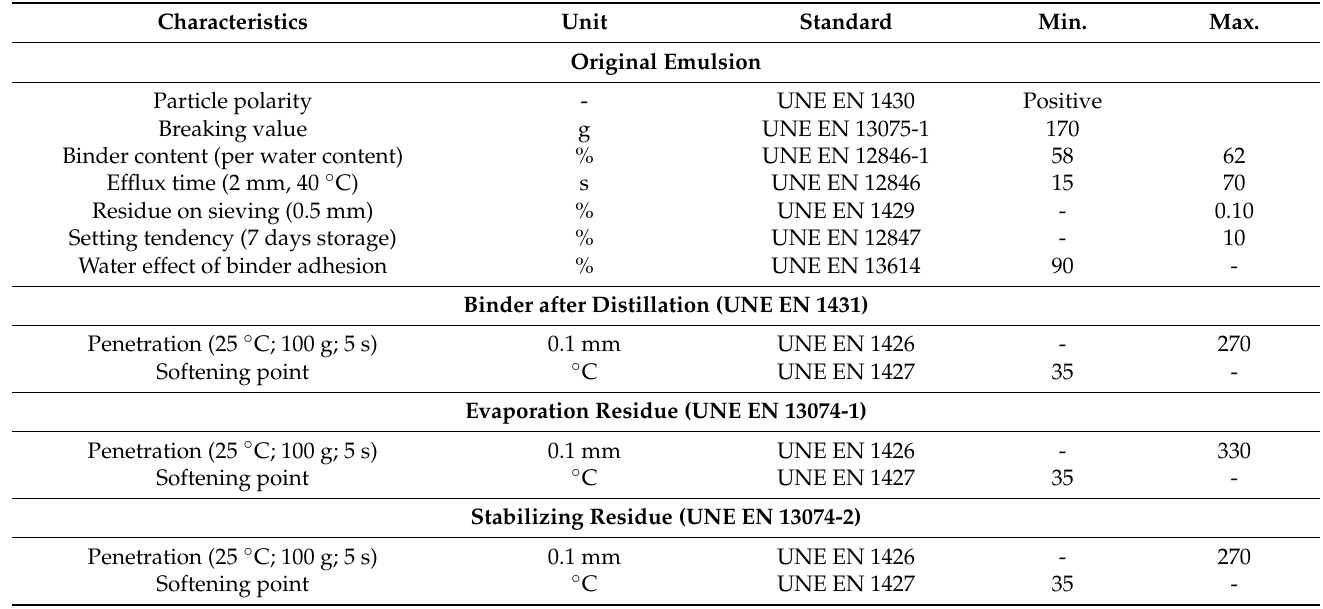
Table 1. Technical details of the bitumen emulsion C60B5